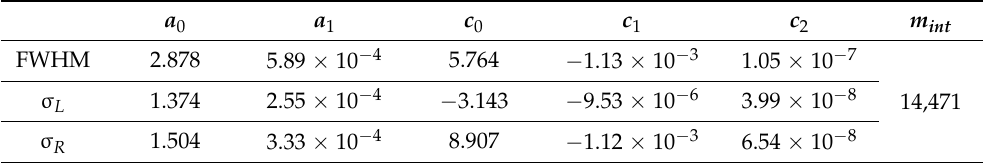
Table 1. The average peak width parameters for the FWHM, and the left and right HWHM for the RapifleX.